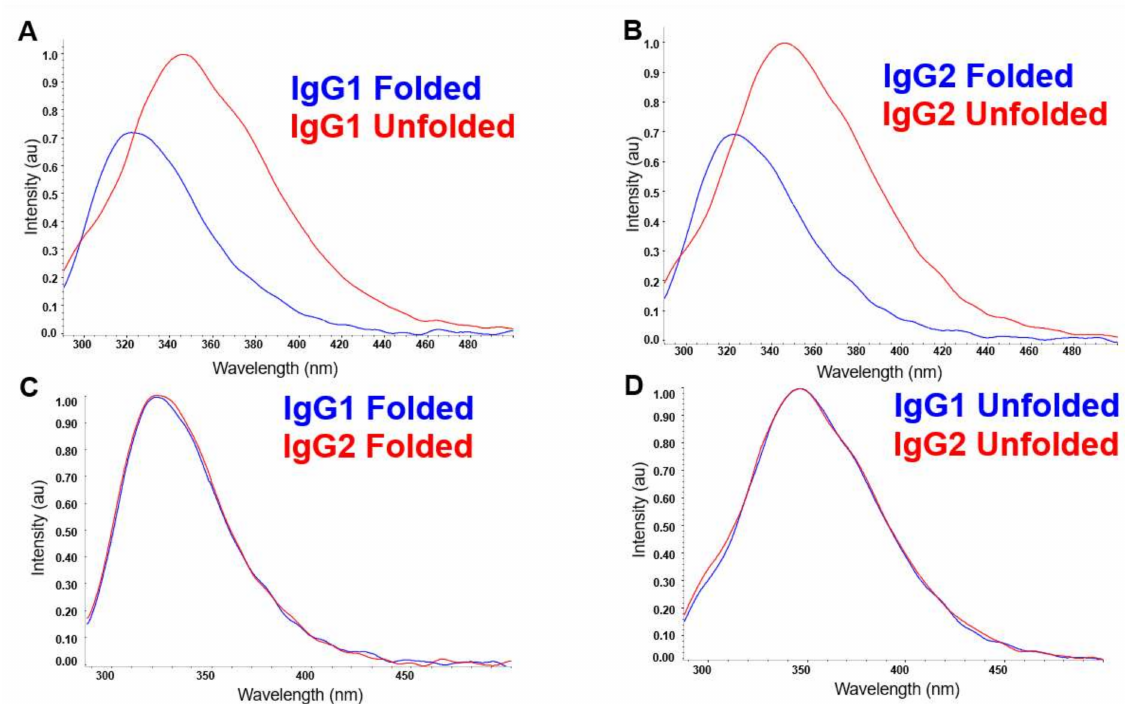
Figure 2. FLD spectra of the folded and unfolded samples of IgG1 ( A ) and IgG2 ( B ). Comparison of the spectra from the folded states of the IgG1 and IgG2 molecules in ( C ), and the unfolded states for these two molecules in ( D